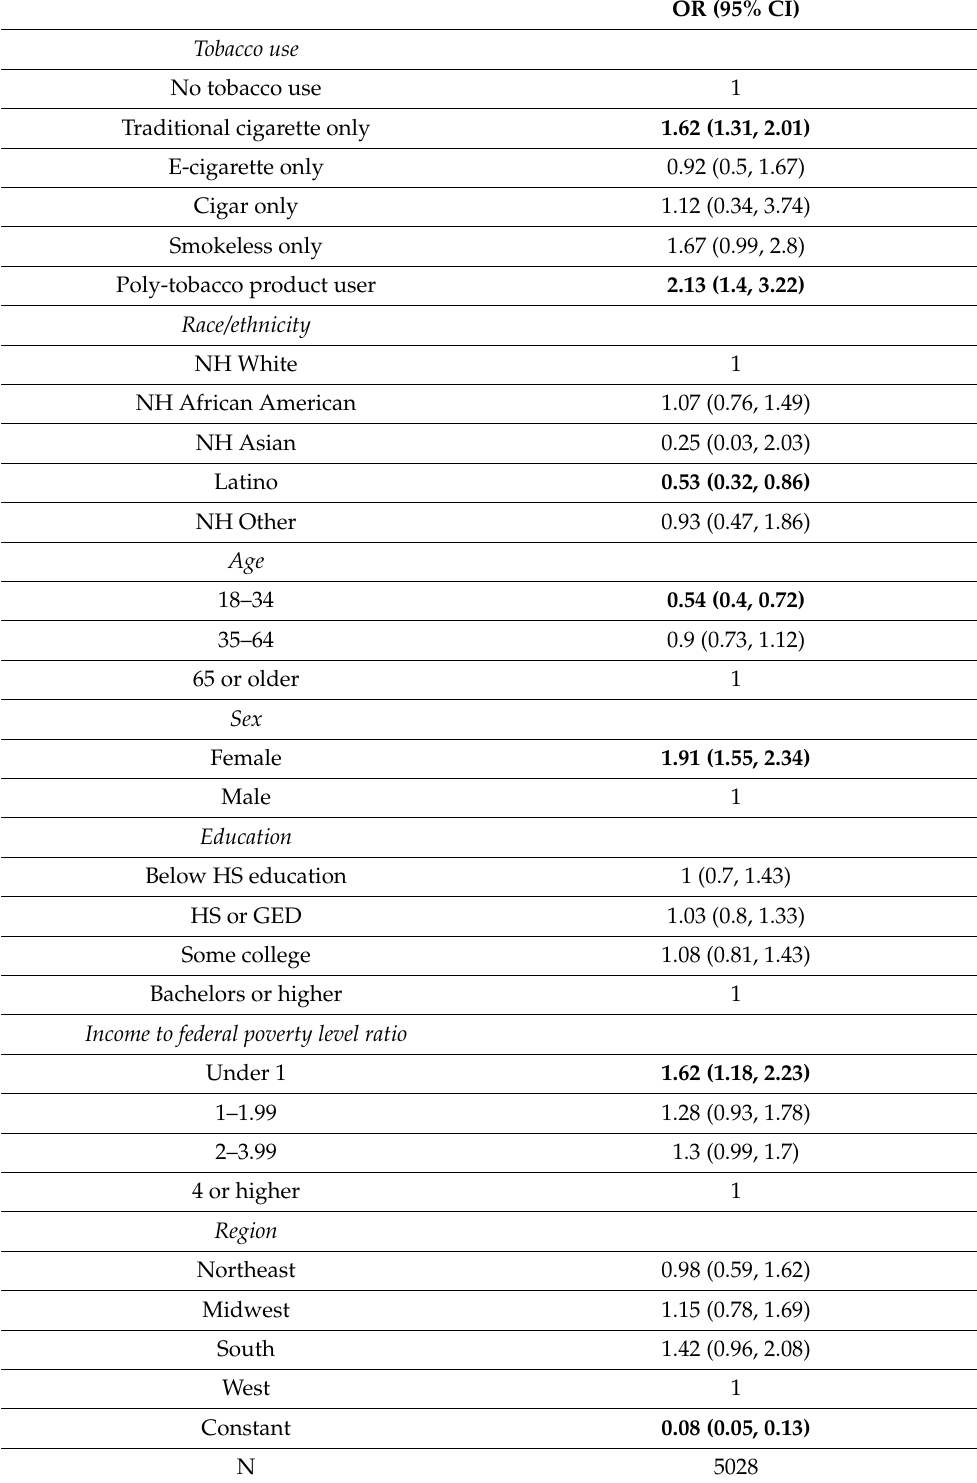
Table 2. Association between tobacco use and medical opioid